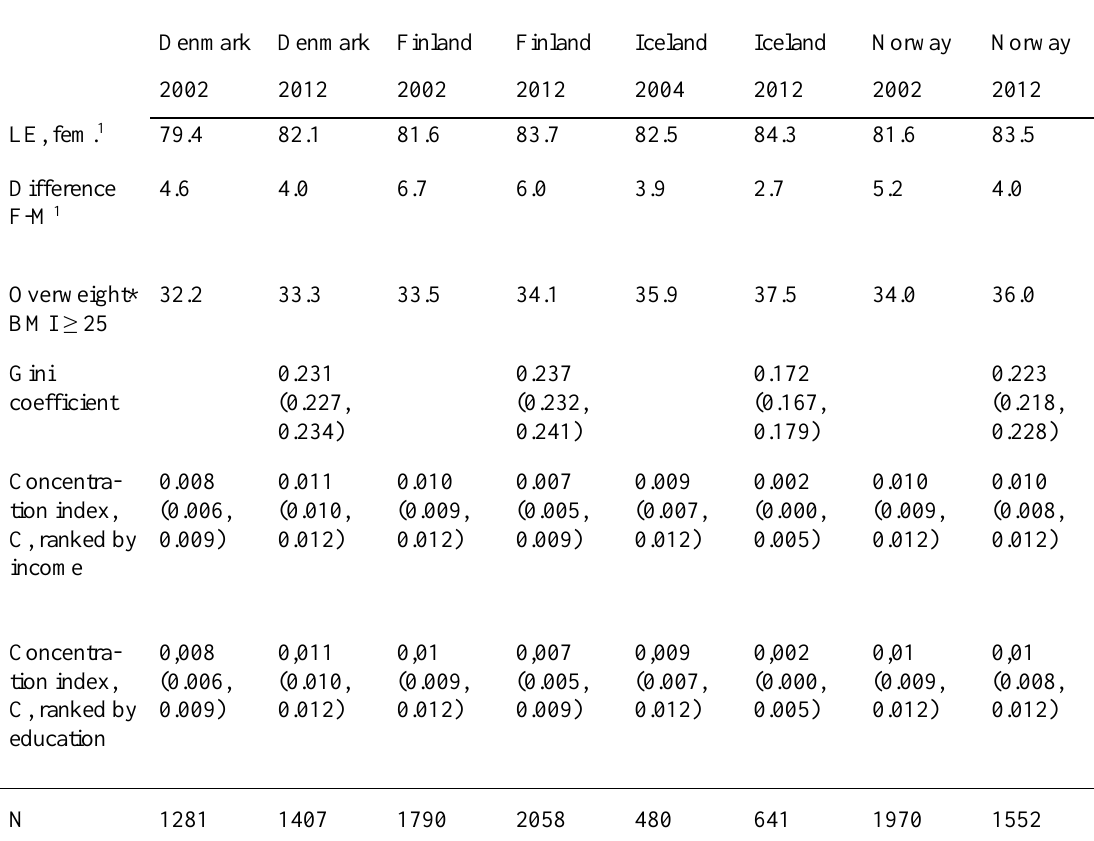
Table 3: Life expectancy, overweight and concentration indices, Nordic countries, UK and Germany 2002 and 2012. Gini coefficients 2012 Denmark